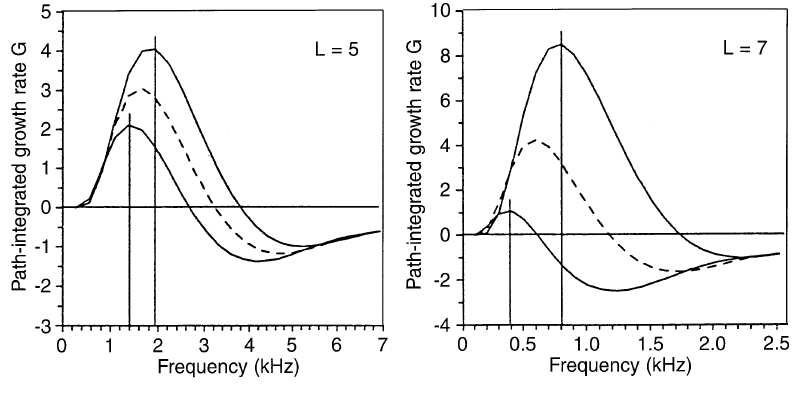
Fig. 8. Theoretical frequency-time diagrams of path-integrated growth rates for two L-shells. The time evolution of the relative disturbance amplitude in the equatorial plane at the top panel is shown. Computations are made for magnetosphere plasma para-